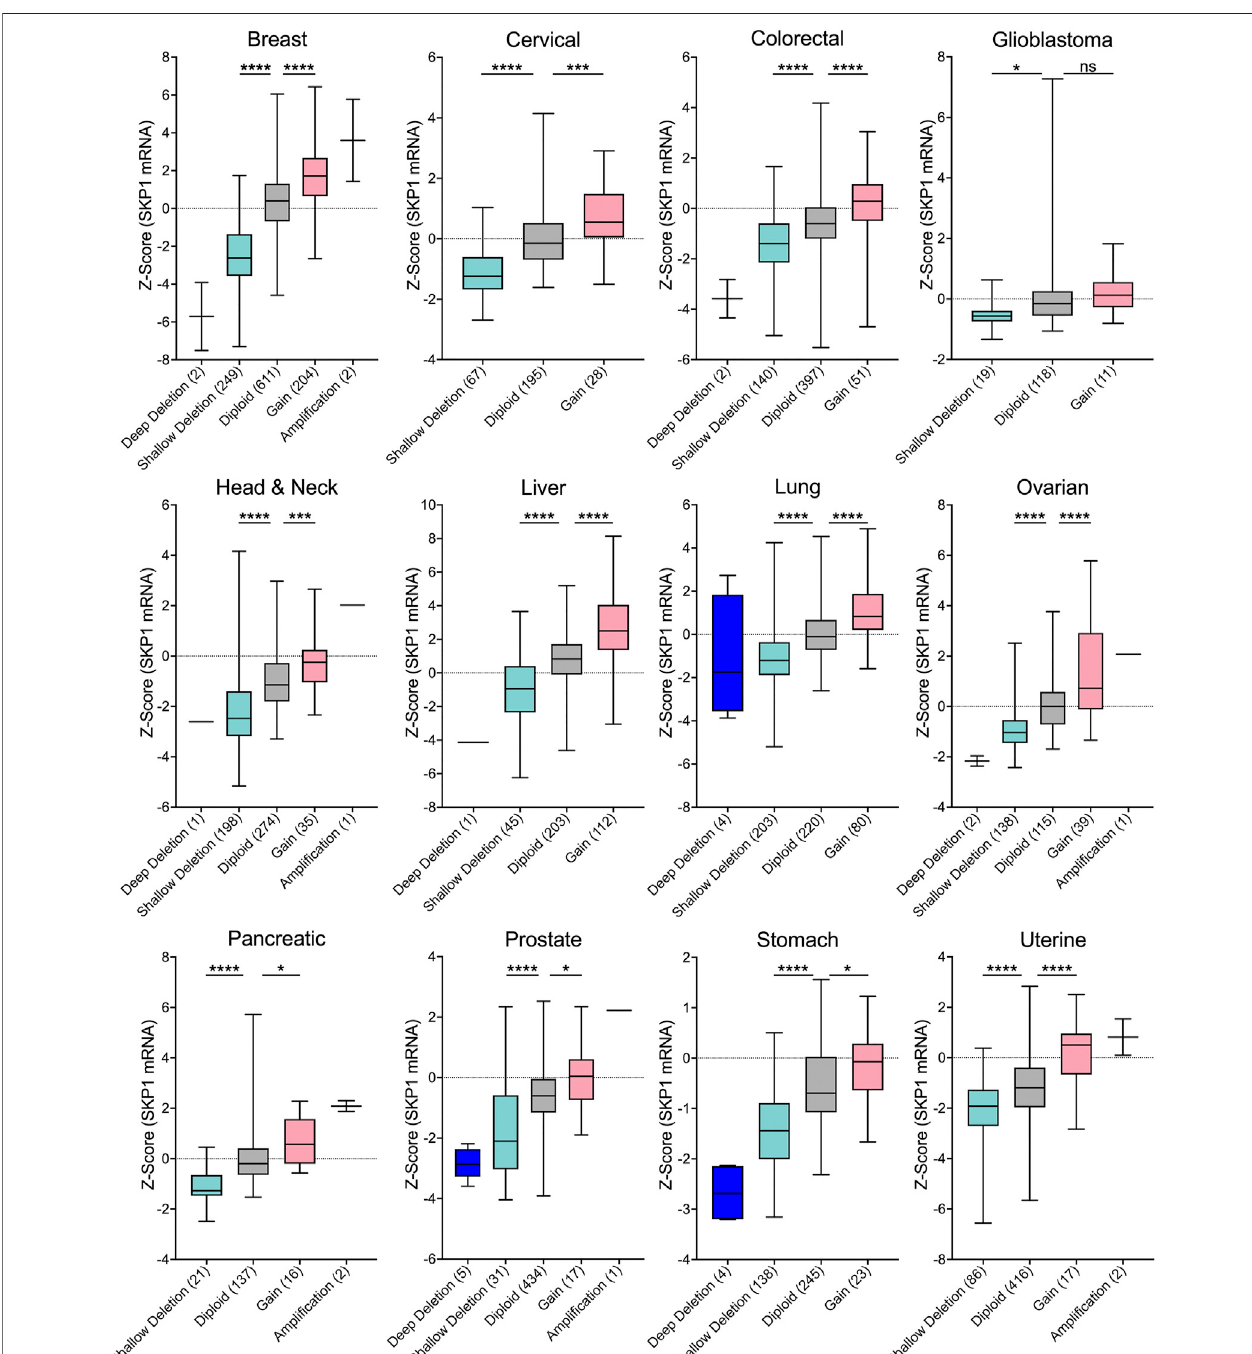
FIGURE 3 | SKP1 Copy Number Alterations are Positively Correlated with mRNA Expression Levels in Cancer. Box-and-whisker plots of TCGA pan-cancer data from 12 common cancer types reveal linear correlations between SKP1 copy number alterations and mRNA expression levels (Cerami et al., 2012; Gao et al., 2013; Hoadley et al., 2018). Boxes identify interquartile ranges (25th, 50th, and 75th percentiles), while whiskers depict entire range. For orientation purposes, the dotted horizontal lines identify 0. Speci fi c copy number alterations (deep deletion; shallow deletion; gain; amp) and diploid categories are presented along the x -axis with the total number of samples indicated within brackets. Unpaired t-tests were conducted comparing either Shallow Deletions or Gains with the corresponding Diploid control (ns [not signi fi cant] p -value > 0.05; * p -value < 0.05; *** p -value < 0.001; **** p -value < 0.0001). Note that in general, very few deep deletions or ampli fi cations were identi fi ed in the 12 cancer